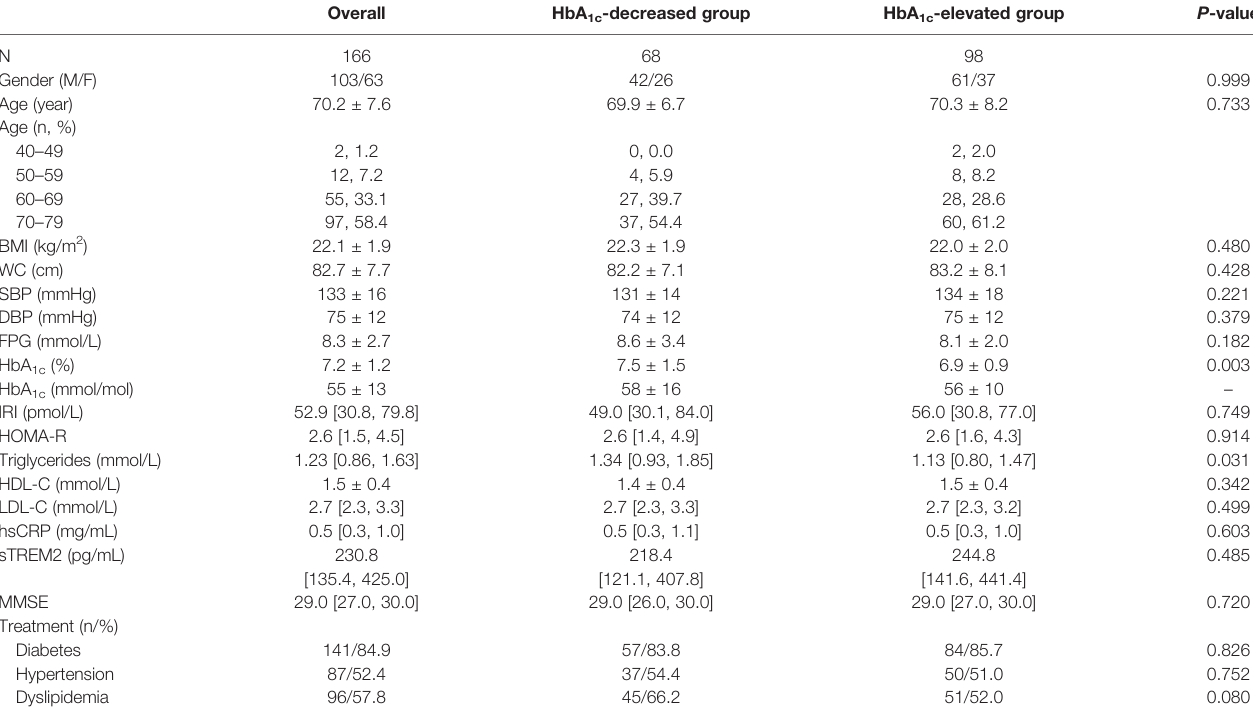
TABLE 1 | Baseline characteristics of patients with decreased- or elevated-HbA 1c after 2-year follow-up. Overall HbA 1c -decreased group HbA 1c -elevated group P -value